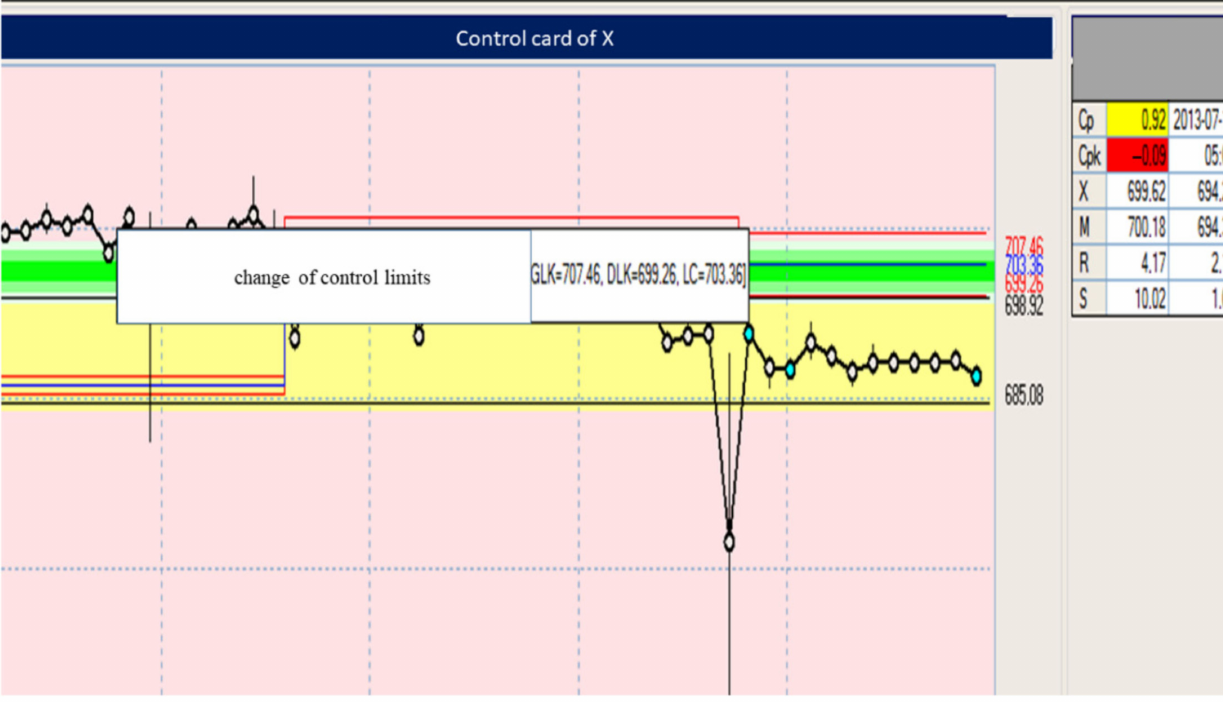
Figure 24. The image showing the parameters adjustment—the effect of reducing the weight of the part.